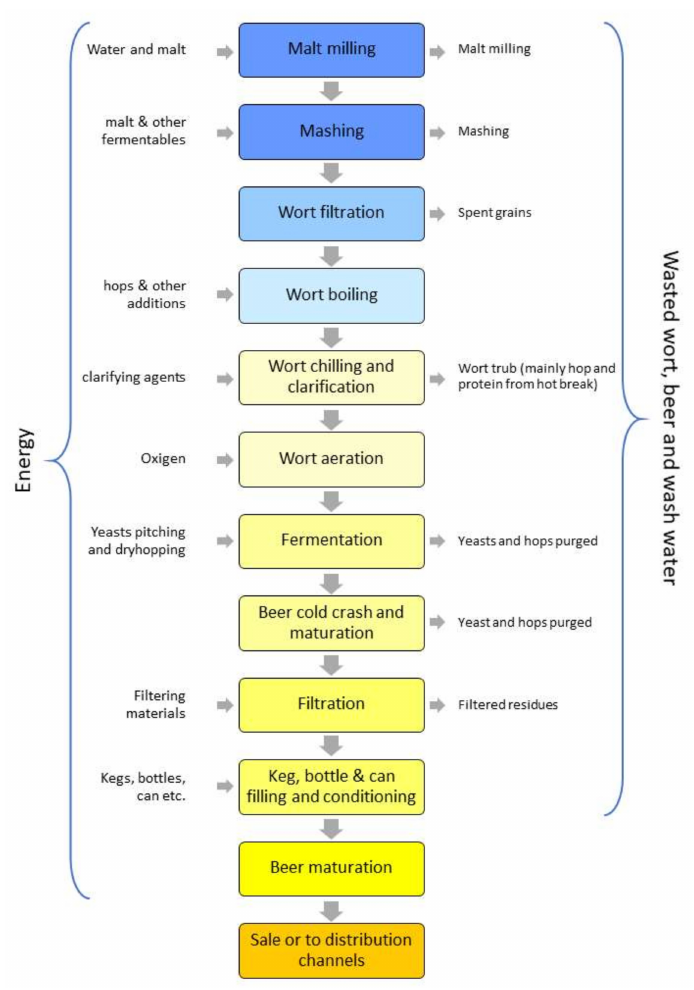
Figure 1. Brewing process and relative input / output involved inspired by Nimbalkar et al.